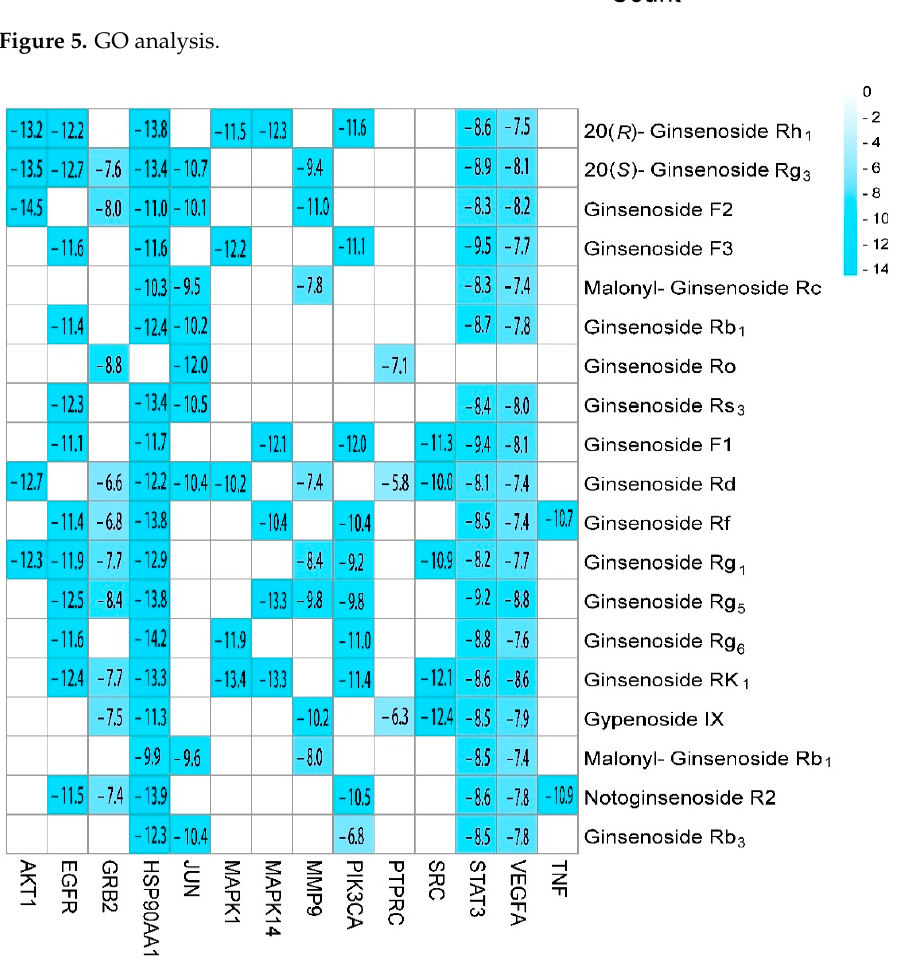
Figure 5 . GO analysis. Figure 5. GO analysis.